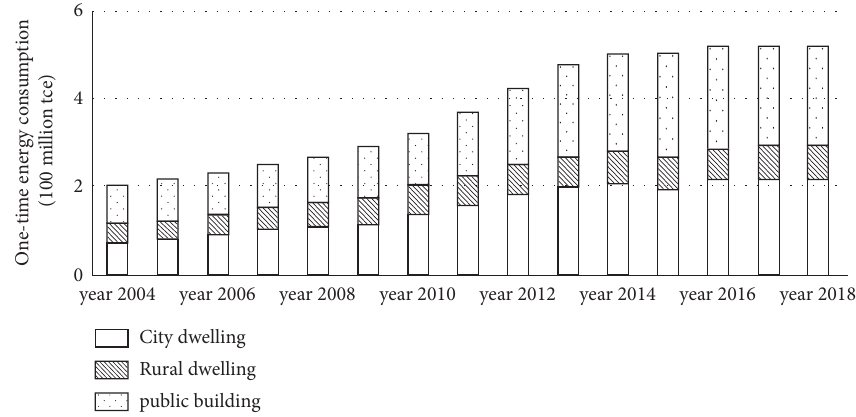
Figure 1: China’s civil building construction energy consumption (2004–2018). Data source: estimated by the Building Energy Research Center of Tsinghua